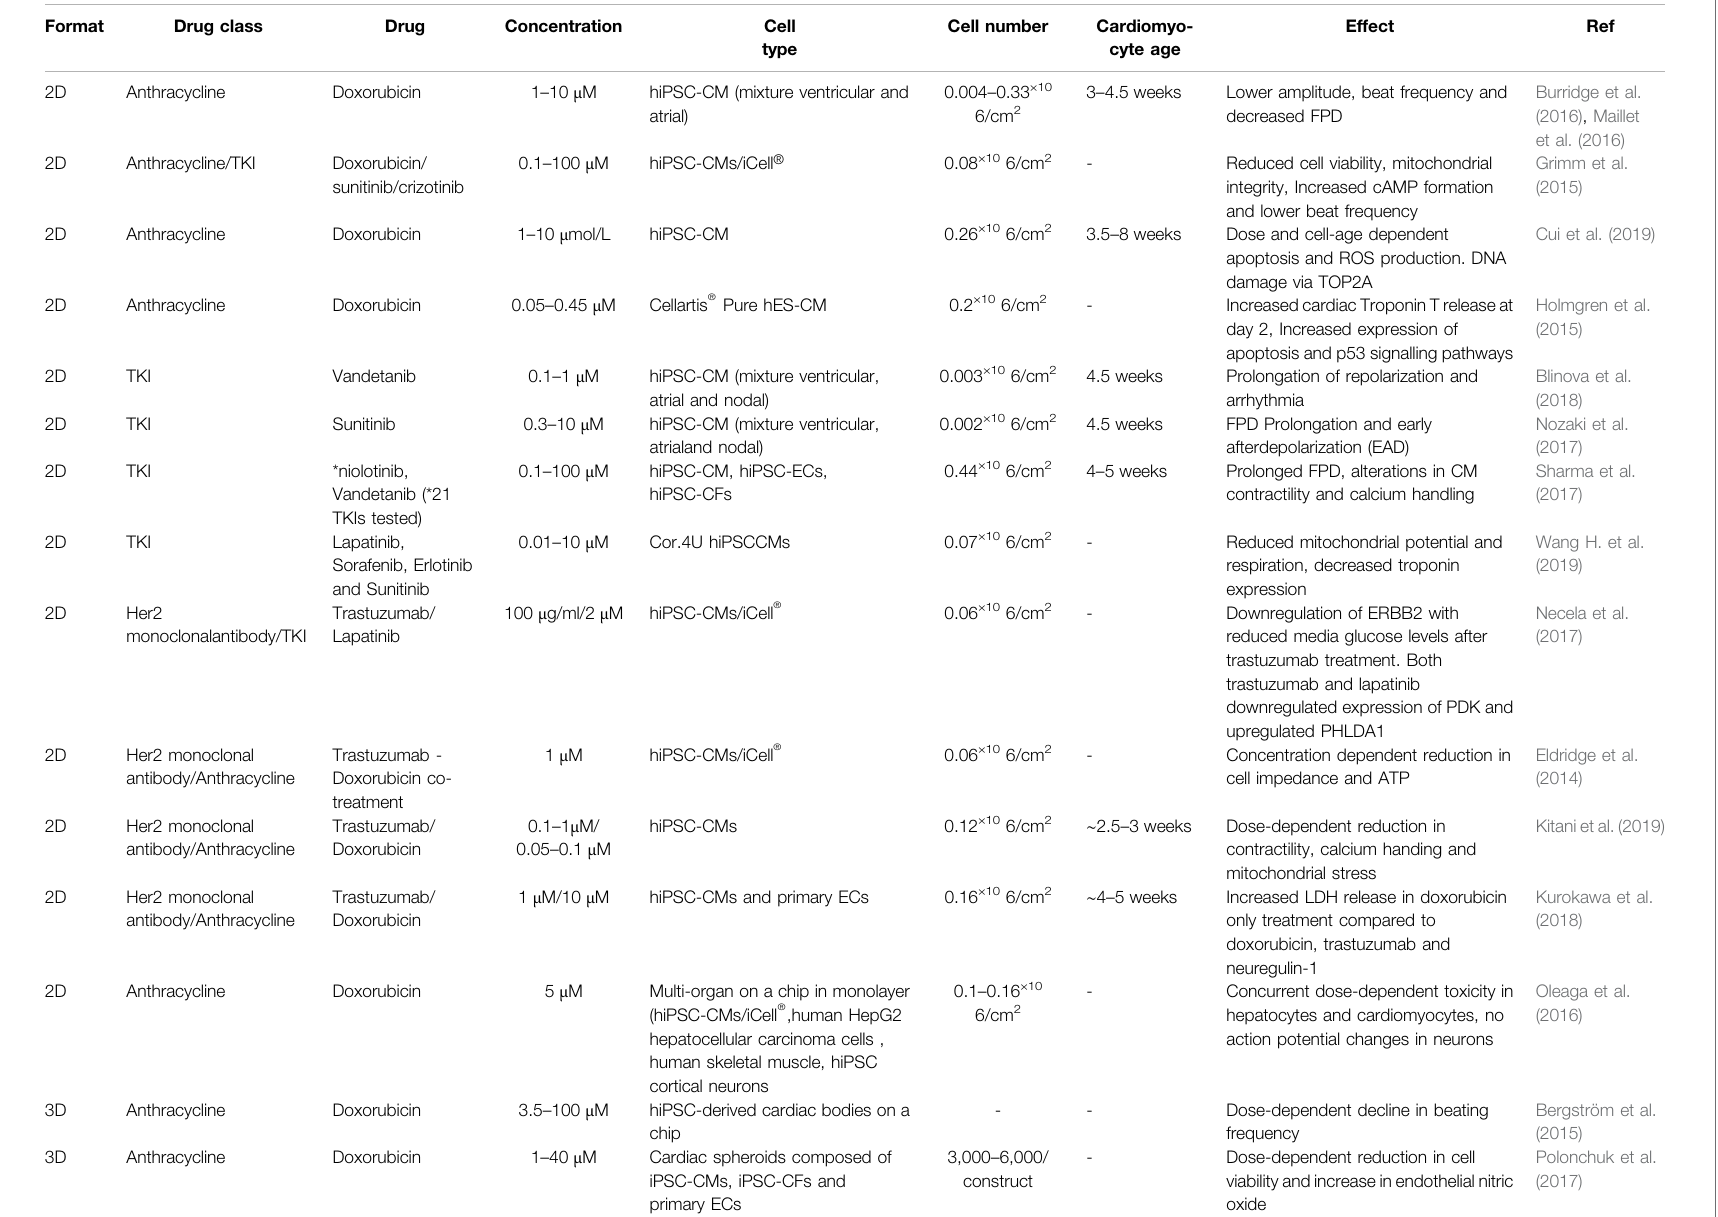
TABLE 1 | A summary of in vitro stem cell-based cardiac models for cancer drug